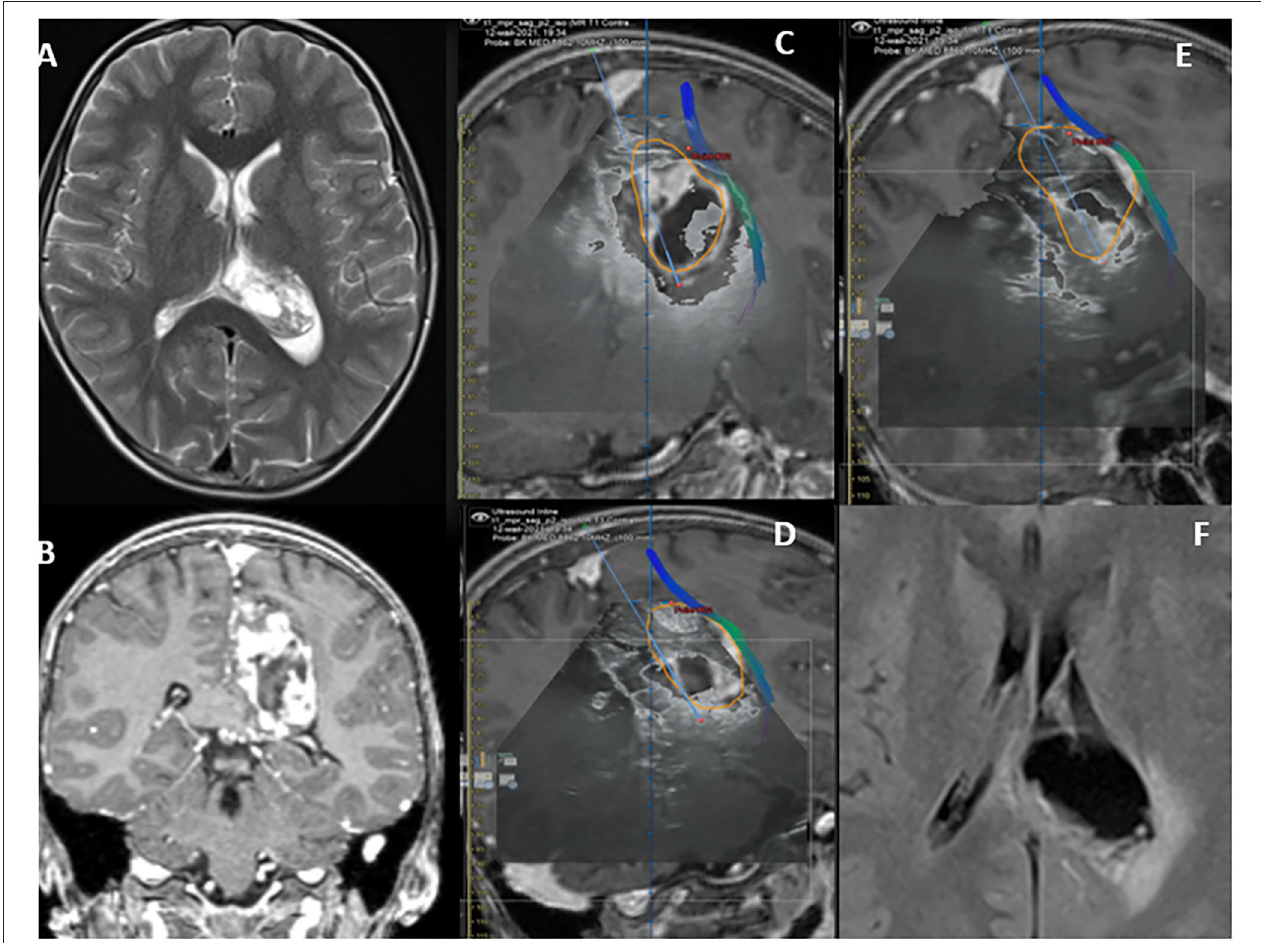
FIGURE 5 | MRI T2 WI Axial parietal- intraventricular cystic lesion (A) . Heterogeneous enhancing on T1WI-C as depicted on its coronal section (B) . The lesion boundaries are depicted in orange on (C–E) , illustrating “Brain shift.” Lesion in close proximity with the cortical spinal tracts. Plain axial post-operative TIWI depicting complete resection of the